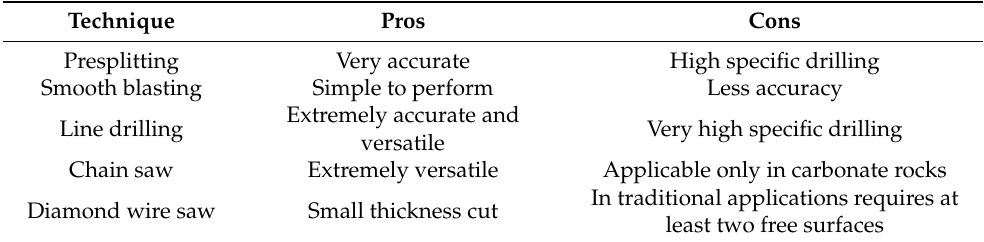
Table 4. Pros and cons of the contour excavation techniques described. Technique Pros Cons Presplitting Very accurate High specific drilling Smooth blasting Simple to perform Less accuracy Extremely accurate and Very high specific drilling Line drilling versatile Chain saw Extremely versatile Applicable only in carbonate rocks In traditional applications requires at Diamond wire saw Small thickness cut least two free